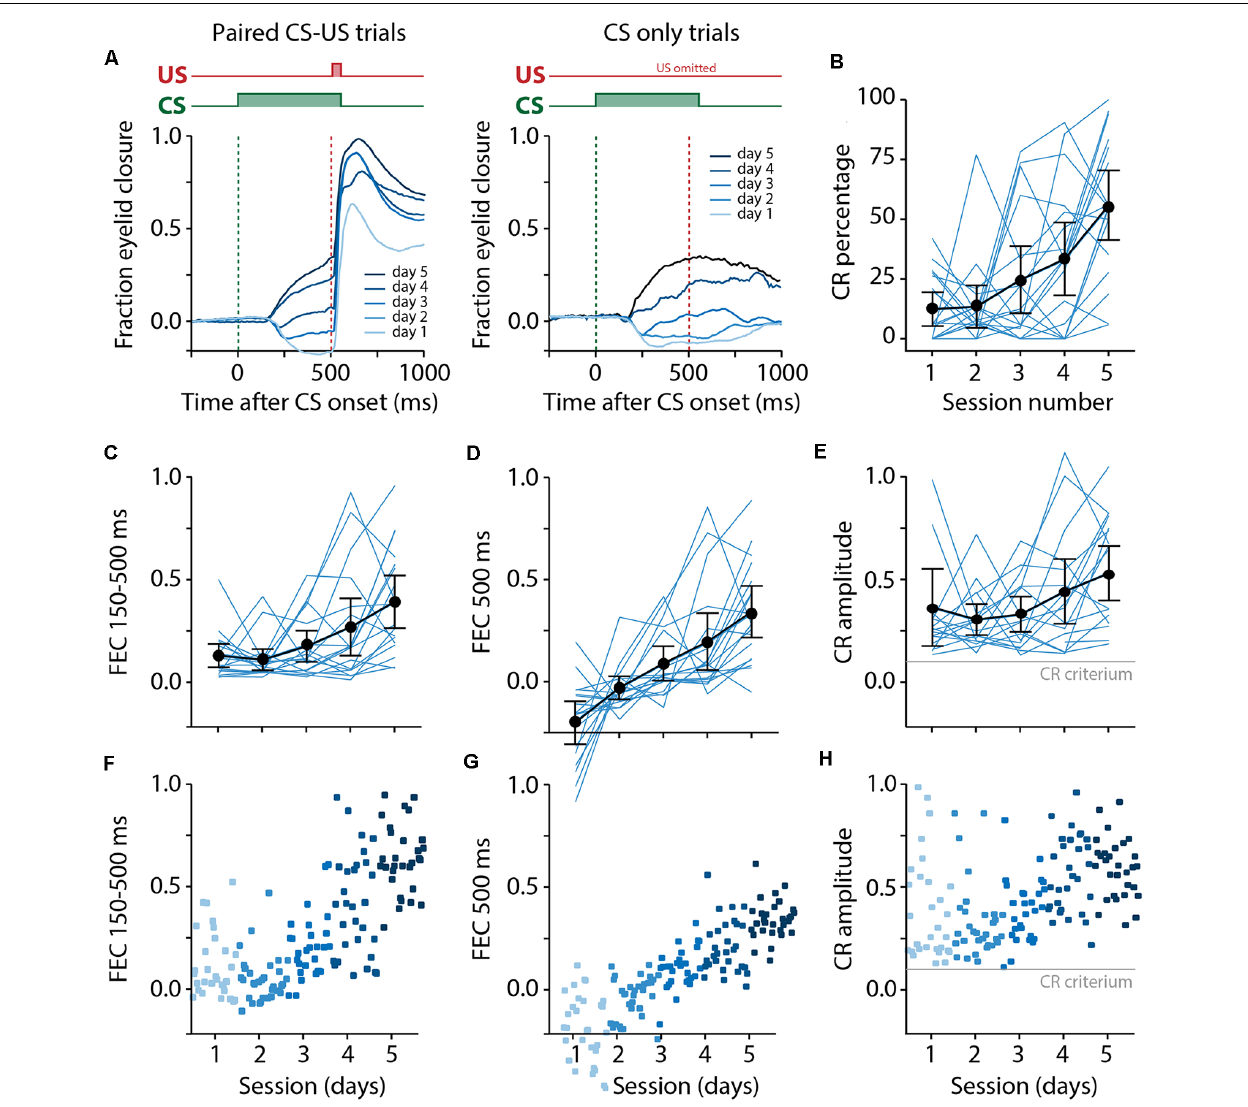
FIGURE 5 | Pigs learn the eyeblink conditioning task, shown by a gradual increase of the CR probability and amplitude of eyelid responses to the CS. (A) Averaged eyeblink traces for each training session for CS-US trials (left) and CS only trials (right). A FEC of 0 corresponds with full eye-opening, while an FEC of 1 corresponds with a full eyelid closure. During the first and second training sessions, the averaged eyeblink traces exhibit a prominent eye-opening in response to the CS. Prolonged training (sessions 3–5) resulted in eyelid closures in response to the CS, which are considered as conditioned responses (CR). (B) Individual pig learning curves (thin light blue lines) and group-averaged learning curve (thick black line) showing the CR probability as a function training session. Error bars indicate the 95% confidence interval. A statistically significant effect of the session was found for CR probability. (C–E) Individual pig learning curves (thin light blue lines) and group-averaged learning curve (thick black line) as a function of session. Error bars indicate the 95% confidence interval. (F–H) Trial-by-trial values whereby each dot represents the average for all values for that trial. The colors (ranging from light blue to dark blue) correspond with the colors of the averaged eyeblink traces in panel (A) . (C,F) The maximum amplitude of the eyelid closure in 150–500 ms interval after CS onset calculated over all trials (FEC 150–500 ). A statistically significant effect of the session was found for FEC 150–500 . (D,G) The amplitude of the eyelid closure at 500 ms after CS onset calculated over all trials (FEC 500 ). A statistically significant effect of the session was found for FEC 500 . (E,H) The maximum amplitude of the eyelid closure in 150–500 ms interval after the onset of the CS calculated over only the trials wherein a CR was present (CRamplitude 150–500 ). A statistically significant effect of the session was found for CRamplitude 150–500 . For all statistical